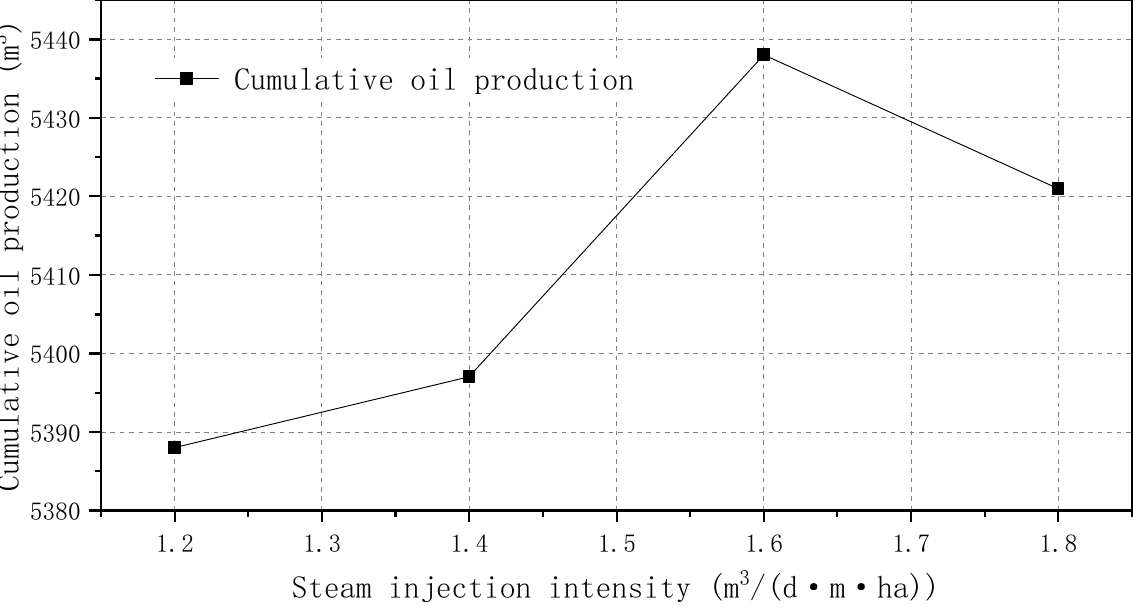
Figure 13. Cumulative oil production at different steam injection intensity. It can be seen from Figure 14 that the mass fraction distribution of heavy components retained in the formation did not change much with increasing steam injection intensity with steam breakthrough in the production well, that is, different steam injection intensities have little effect on the retention of heavy components.